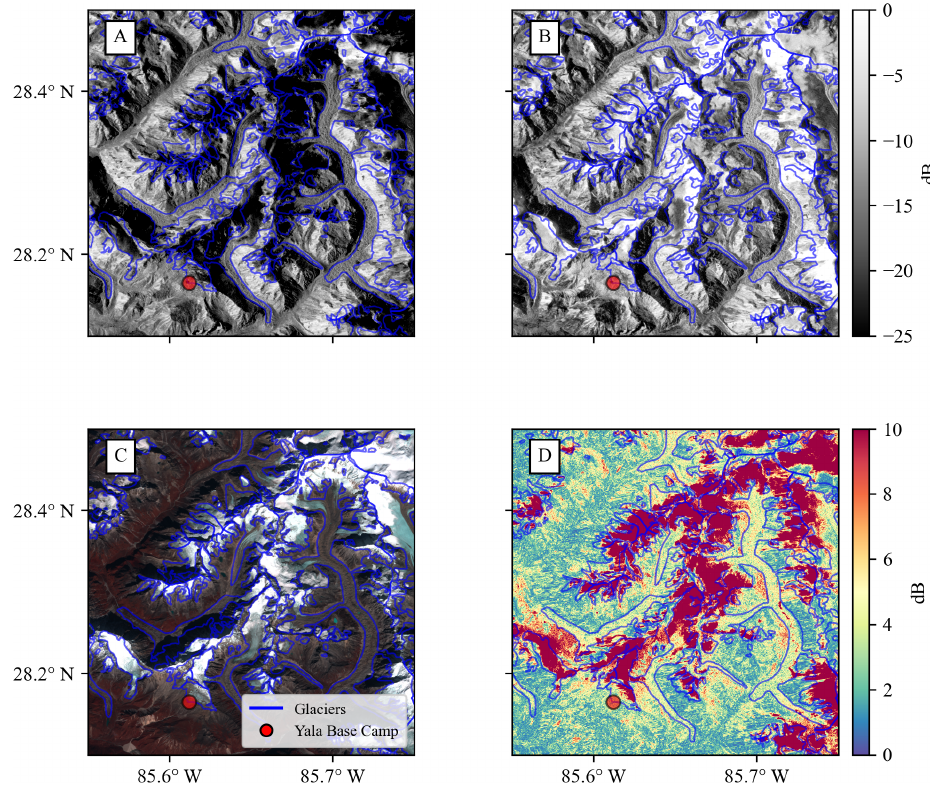
Figure 2. (a) Mean summer (July–August) 2018 cross-polarized (VH) backscatter across an example region in the Trishuli basin, Nepal. (b) Mean 2018 winter (January–February) VH backscatter from Sentinel-1. (c) Sentinel-2 false-color (near-infrared, green, blue) image acquired by Sentinel-2 on 30 October 2018. Glacier outlines are shown in blue, and the Yala Glacier base camp meteorological station is marked in red. Note the snow-covered and bare-ice portions of outlined glaciers and other debris-covered portions of glacier ablation areas. (d) The difference between mean summer and winter VH backscatter from Sentinel-1. Table 1. Sentinel-1 image count and orbit paths used in this